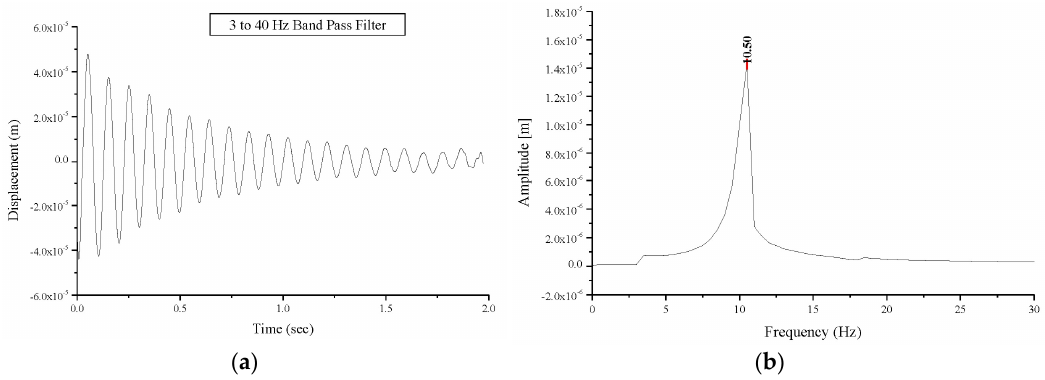
Figure 10. Free oscillations’ response of the damaged vault BV1: ( a ) displacement versus time; ( b ) Fourier transform: amplitude versus frequency.